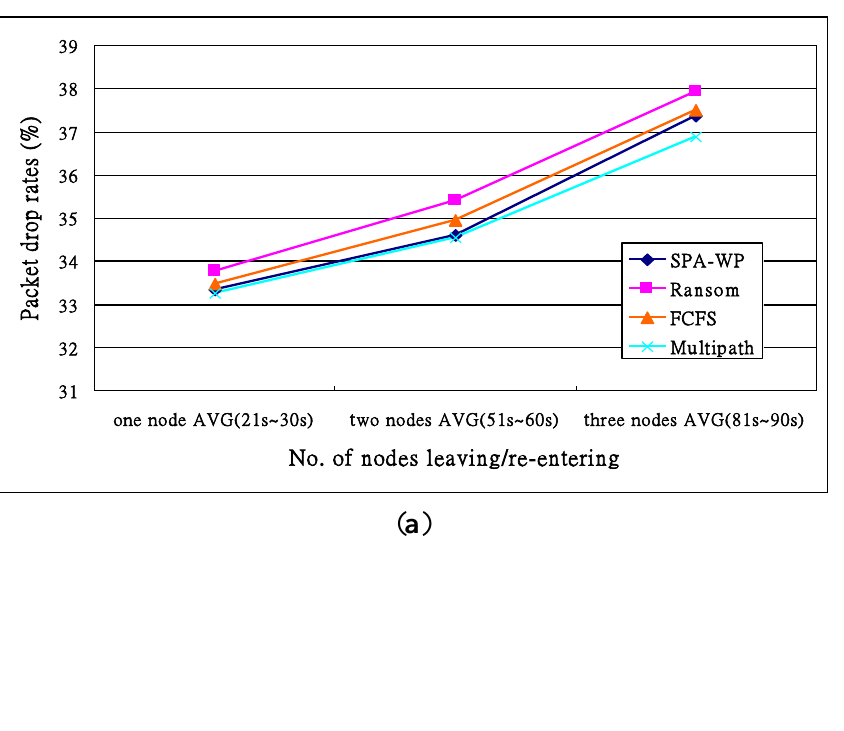
Figure 14. Performance of the cases in which nodes leave and re-enter the tested systems. ( a ) Drop rates; ( b ) Throughputs; ( c ) Throughputs against time